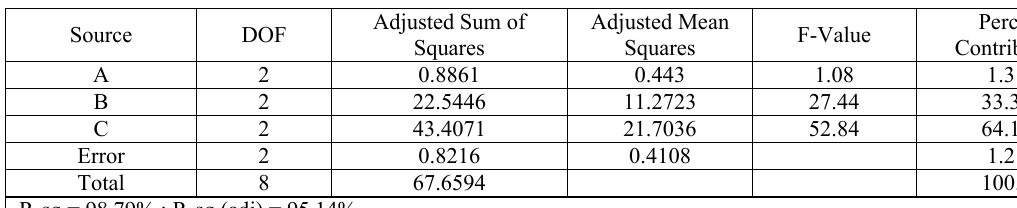
Figure 4. Main effects plot of S/N ratios Table 5. Analysis of variance of S/N ratios